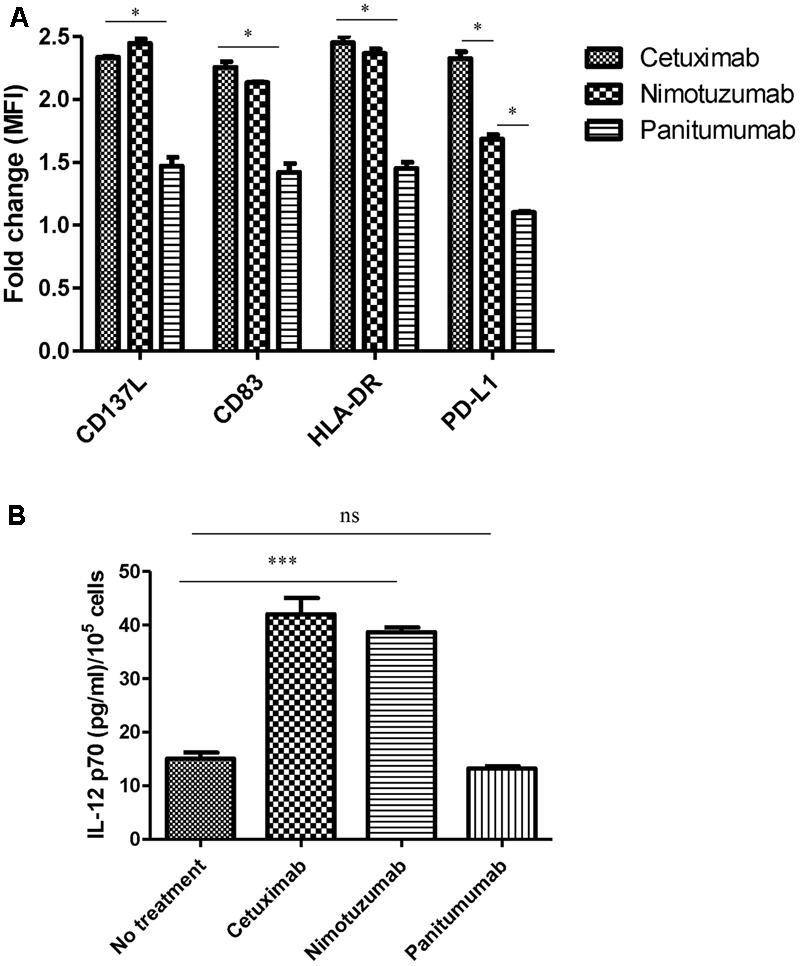
Change on DC marker levels and IL-12 secretion by nimotuzumab-activated NK cells. (A) Analysis of CD83/HLA-DR/CD137L/PD-L1 expression on DC co-cultured with NK: PCI-15B with no treatment or in the presence of cetuximab or panitumumab or nimotuzumab (each 10 μg/mL, 48 h). Expression levels of molecules are represented in fold change of MFI related to levels on control DC co-cultured with NK: PCI-15B alone (no treatment). Significant upregulation of CD83/HLA-DR/CD13L were obtained with the use of nimotuzumab or cetuximab in comparison with co-culture without treatment or with panitumumab (∗p < 0.05). A two-tailed unpaired test was conducted for statistical analysis. Data are representative of three experiments from five different donors. Nimotuzumab induces significant less upregulation of the inhibitory marker PD-L1 on DC as compared with cetuximab (∗p < 0.05). Data are representative of two experiments from four different donors. (B) Enhancement by nimotuzumab of IL-12 secretion in DC-NK co-culture. The level of IL-12 was determine in the supernatant from co-culture of 3 × 105 DC: NK: PCI-15B (1:1:1 ratio) incubated with no treatment or with nimotuzumab or cetuximab or panitumumab (each at 10 mg/mL for 48 h). Values are mean ± SEM of two independent experiments from two separate donors. Similar values were obtained for nimotuzumab and cetuximab while no treatment or panitumumab incubation didn’t induce IL-12 secretion (∗∗∗p < 0.001). A two-tailed unpaired test was conducted for statistical analysis.